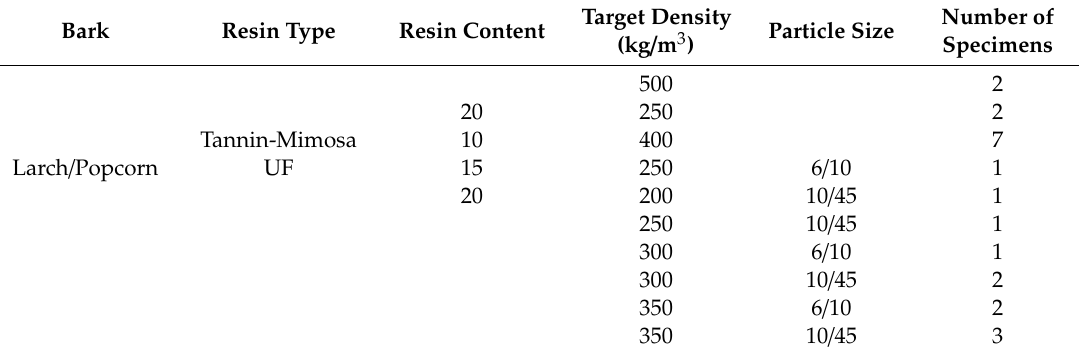
Figure 2. CT-tomograms, resolution 30 µm; ( a ) larch bark insulation panel, 417 kg/m³, thickness 20 mm; ( b ) larch bark + popcorn (50 wt-%), 257 kg/m³, thickness 20 mm.